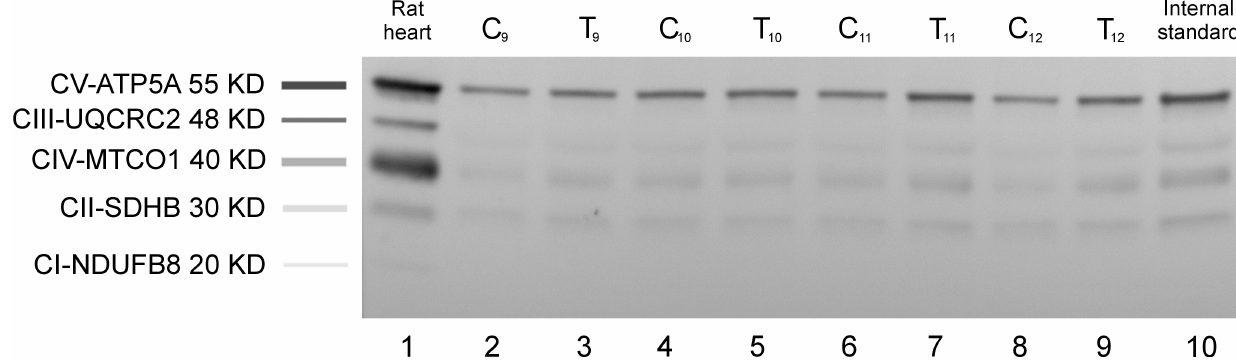
Fig 1. Respiratory chain proteins subunits in MGF of control and trained animals. Western blot analysis of protein extract from the fast part of the medial gastrocnemius (MGF) of control (C 9 –C 12 ) and trained rats (T 9 –T 12 ), using primary antibodies against respiratory chain proteins subunits (ab110413). Lane 1 contains rat heart mitochondrial lysate as the positive control and lane 10 –rat muscle sample (m. gastrocnemius) as the internal standard.